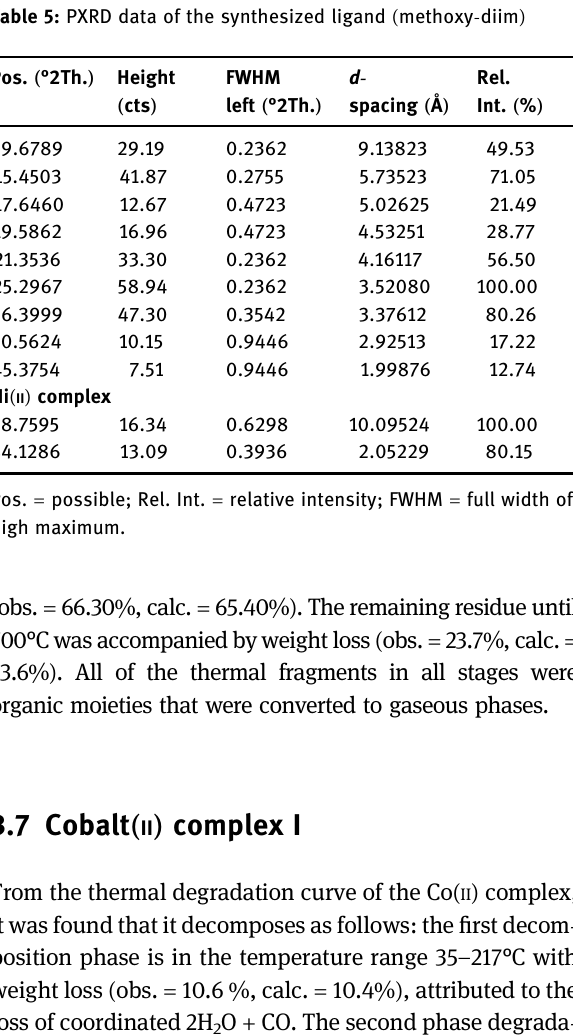
Table 5: PXRD data of the synthesized ligand ( methoxy - diim )